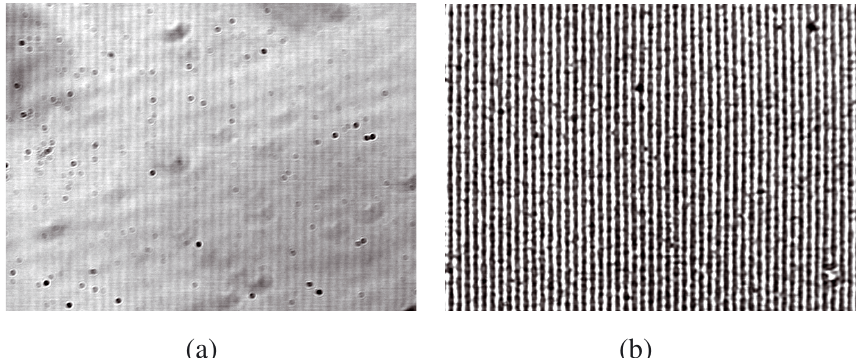
Fig. 2. Images of the grating under top reflected white light illumination (a) without aluminum coating and (b) with aluminum coating.